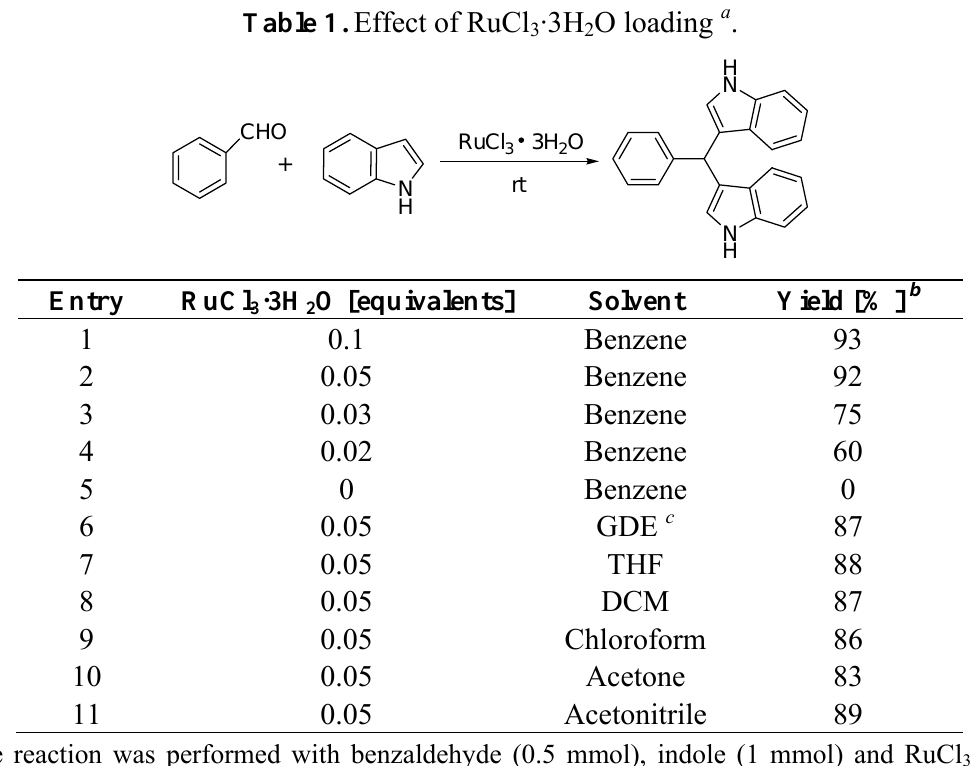
Table 1. Effect of RuCl